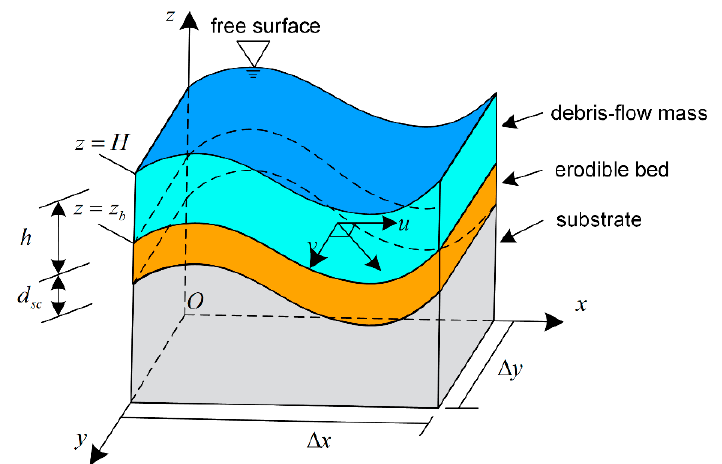
Figure 4. Overview of the debris- fl ow numerical model.